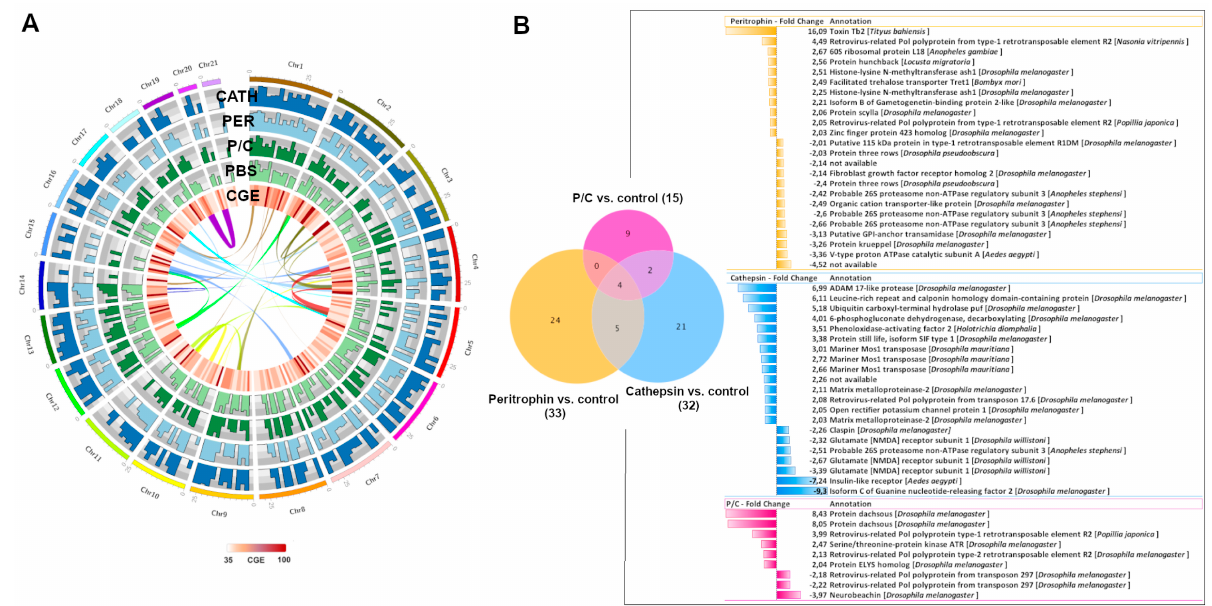
Figure 4. Whole-genome transcription profile of C. rogercresseyi collected from vaccinated fish. ( A ) Chromosome regions with CGE index variation > 60. Histograms show the coverage of transcripts from different chromosomes. Heatmap in red showed the expression variation among the four groups. ( B ) Venn diagram showing the distribution of contigs differentially expressed. Bars represent fold change values of annotated genes. (Fold Change ≥ |2|; FDR = 0.05).